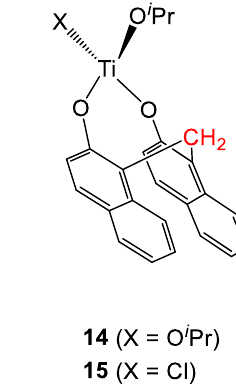
Figure 4. Molecular structures of complexes 6 (left), 8 (center) and 10 (right) [8].